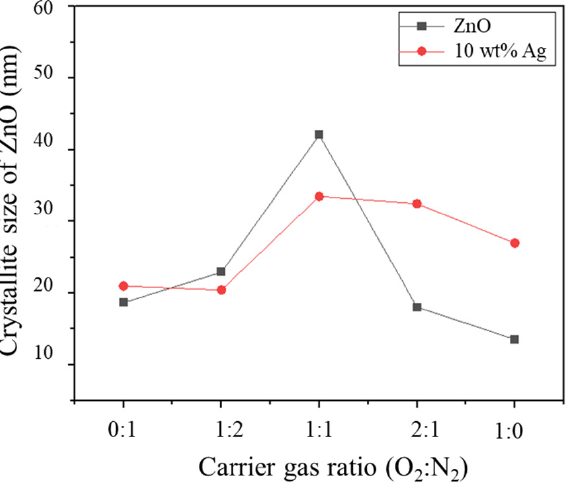
Figure 5. Crystallite size of ZnO at different carrier gas ratios and Ag contents.